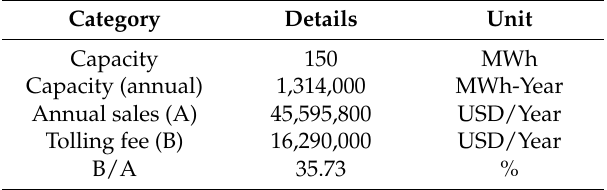
Table 2. Tolling fee of one-year energies contract (modified from [24]).